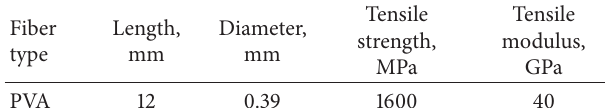
Table 1: Properties of PVA fiber.